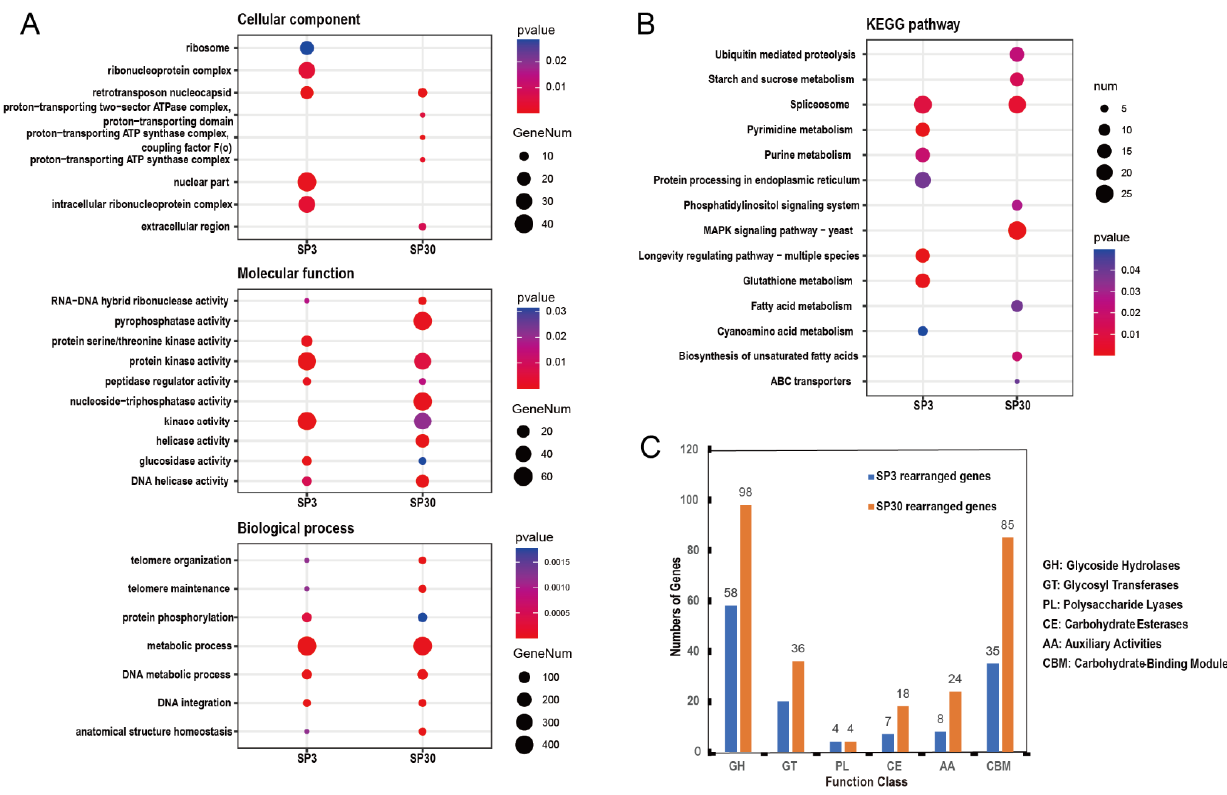
Figure 4. Cluster analysis of the two monokaryon-specific genes in each of the two monokaryons SP3 and SP30. ( A ) GO term analysis of SP3 and SP30 rearranged genes (top five terms of both SP3 and SP30). ( B ) KEGG term analysis of SP3 and SP30 rearranged genes ( p < 0.05). ( C ) Classification of identified CAZymes. In GO and KEGG analysis, the color represents the p -value, the red color depth p -value was less than 0.01, and the blue color depth p -value was less than 0.05. The point size signifies the numbers of SP3 and SP30 rearranged genes.